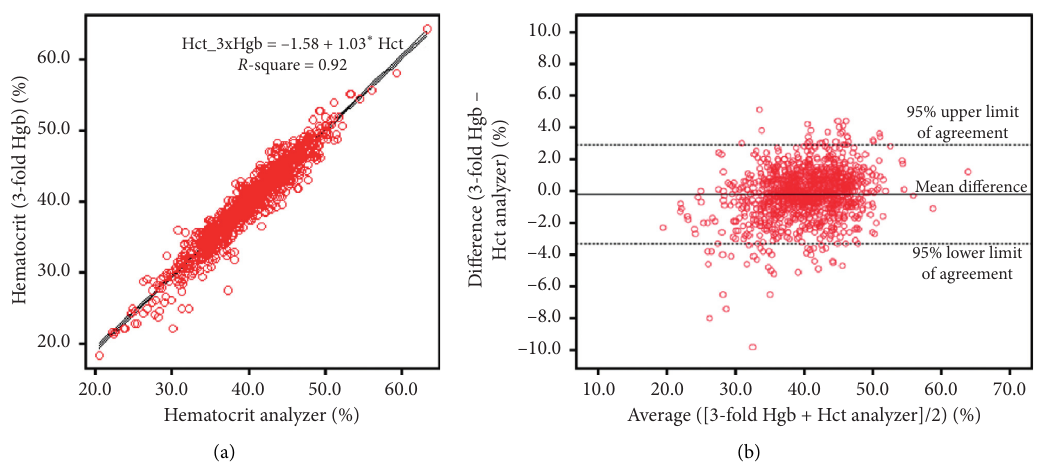
Figure 4: Paired hematocrit of dengue patients calculated from the three-fold conversion and the analyzer. (a) Scatter plots of the 1,141 paired data with hematocrit calculated from the three-fold conversion and the analyzer with best-fitting line. (b) Bland–Altman plot for agreement of data from hematocrit calculated from the three-fold conversion and the analyzer. The mean of the two measurements (horizontal axis) was plotted against the difference between the hematocrit calculated from the three-fold conversion and the analyzer (vertical axis).